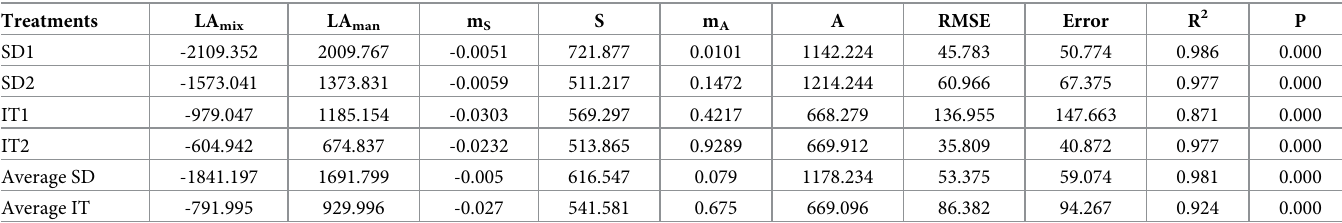
Table 3. Estimated values of the coefficients of Eq 4 for sowing date (SD) and water availability (IT) treatments for leaf area. Treatments LA